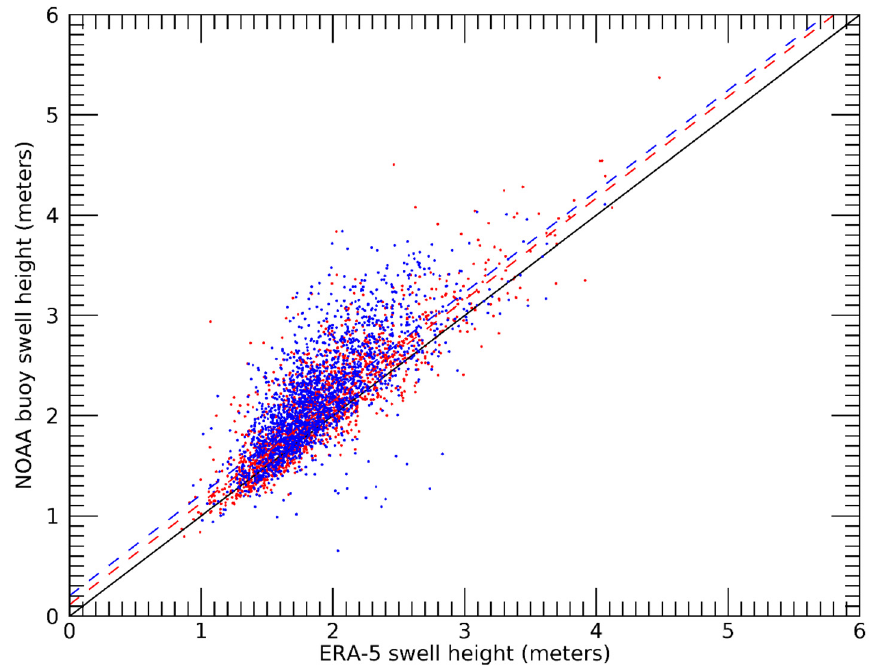
Figure 3. Distribution of daily swell height from ERA5 gridded estimates and NOAA buoy observations from the NOAA buoy 41040 (red) and 41044 (blue) locations. Dashed lines are best fit lines for respective locations and solid black line is the 1:1 line.